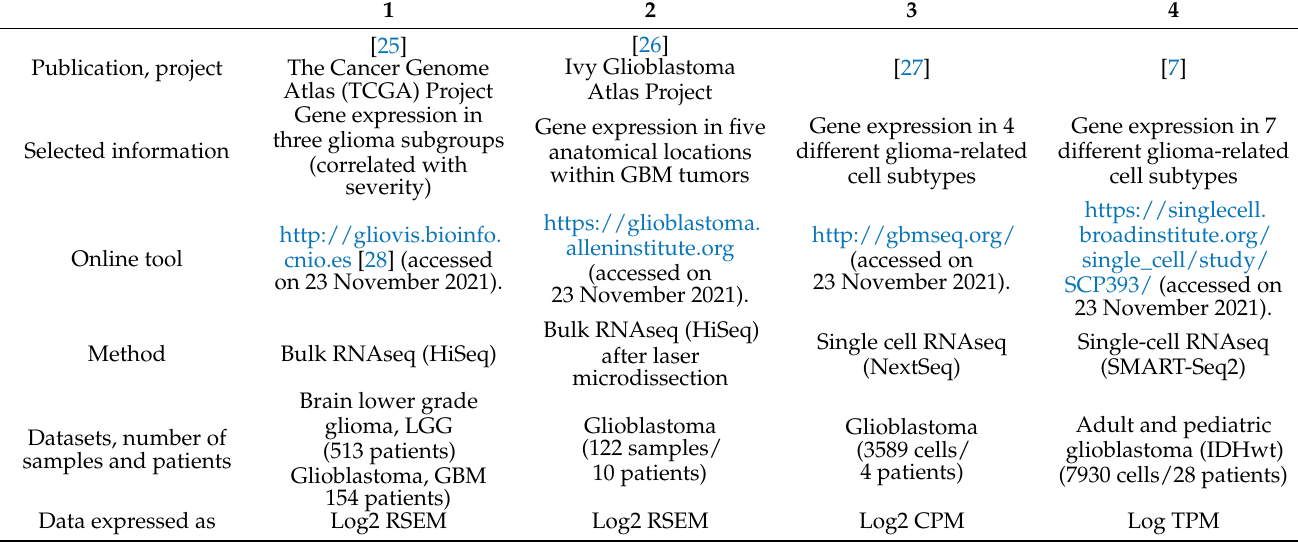
Table 1. General information about the datasets used in the